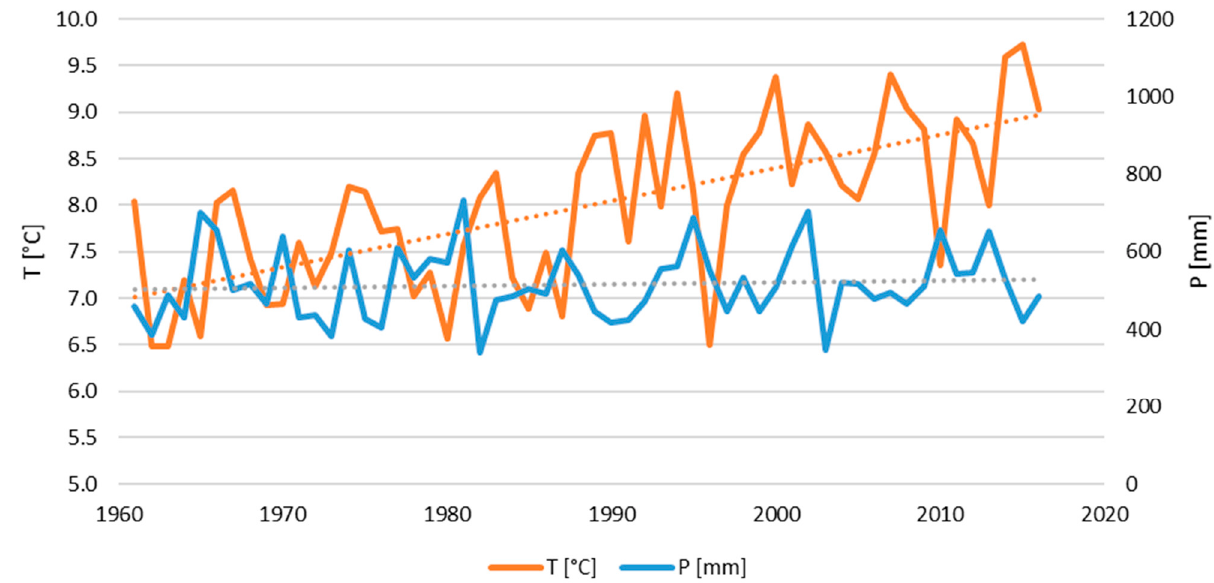
Figure 2. Current climate conditions for the GS Stránky—observed yearly temperatures and precipitations.